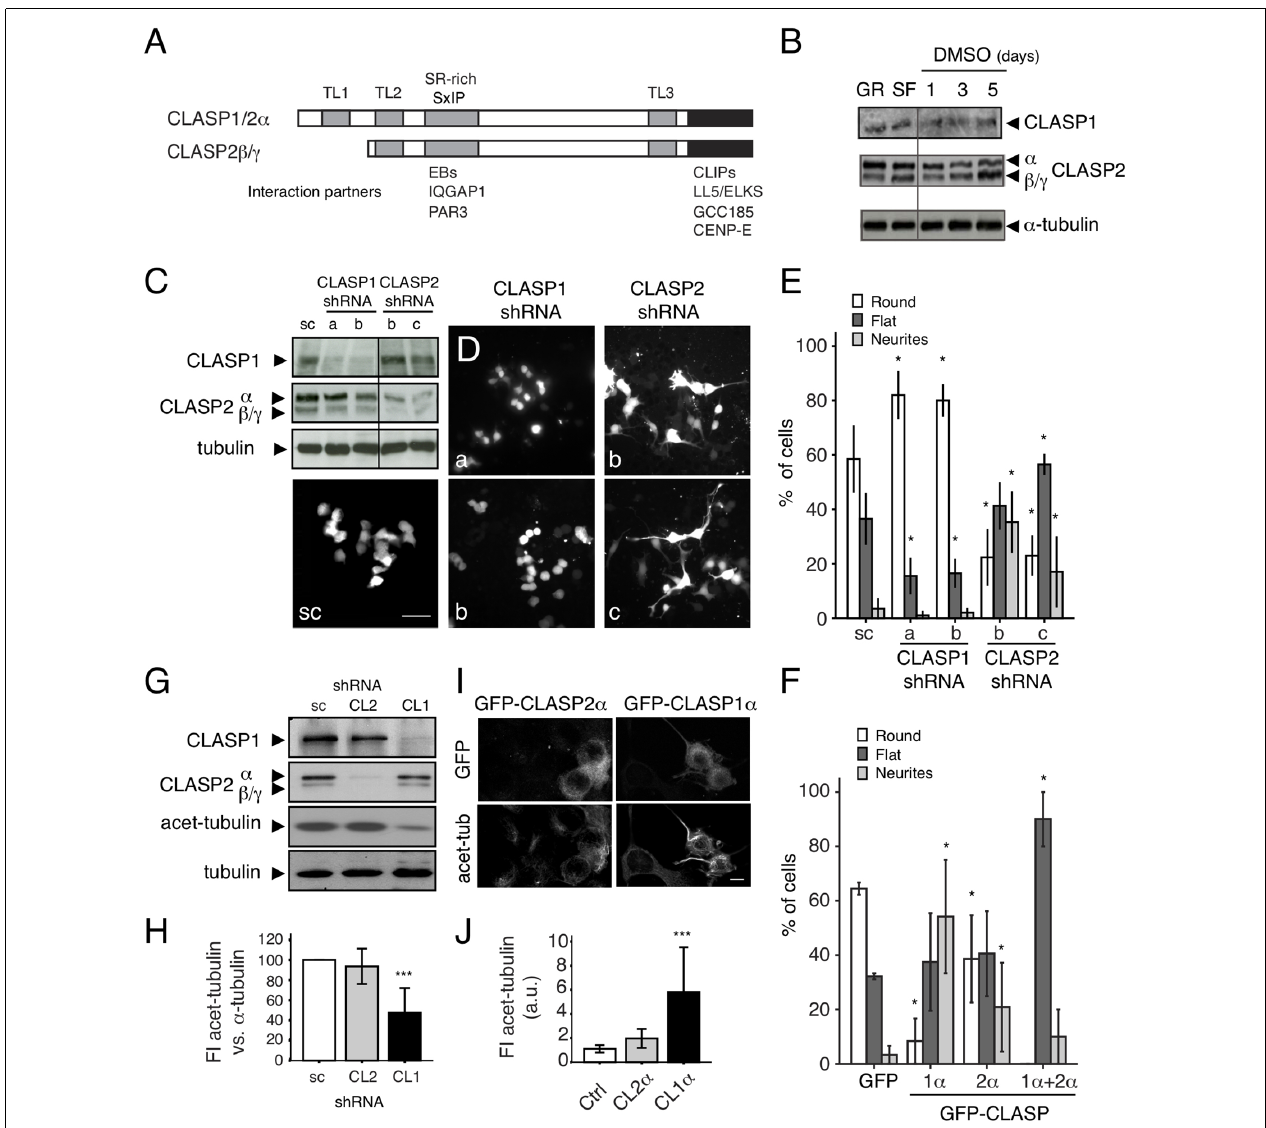
FIGURE 5 | Opposing roles of CLASP1 and CLASP2 in N1E-115 cells. (A) Schematic representation of CLASP domains and isoforms. The position of the TOGL (TL) and serine/arginine-rich (SR-rich) motifs is indicated by gray bars. Interaction partners and the regions in CLASPs with which they interact, are shown underneath. (B) CLASP1 and -2 expression (WB) in N1E-115 cells before and after differentiation, by overnight serum deprivation (SF for Serum Free) or with dimethyl sulfoxide (DMSO) for 1, 3, and 5 days. (C,D) Transient knockdown of CLASP1 and -2 in N1E-115 cells. WBs of lysates (C) and IF staining in N1E-115 cells (D) transfected with a scrambled shRNA construct or with different shRNA constructs targeting CLASP1 or CLASP2 (a and b for CLASP1 and b and c for CLASP2). Cells were either lysed for WB or fixed for IF, 72 h post-transfection. Cells were not serum-starved but were maintained in 10% fetal bovine serum (FBS)-containing medium. In (C) we used anti- α -tubulin as a loading control. In (D) , Scale bar = 50 µ m. shRNA constructs bear GFP as a reporter. (D,E) In the IF experiments, GFP-expressing CLASP1-depleted cells present mostly round morphology, whereas CLASP2-depleted cells show a differentiated morphology (flat or with neurites). This was quantified in E. Number of cells with each different morphology (round, flat or neurite-bearing cells) was compared in cells transfected with either CLASP1-or CLASP2-shRNAs vs. the scramble shRNAs (scramble/control). Student T -tests were performed. The effects had different extents depending on the shRNA used. (F) Overexpression of GFP-CLASP1 α induced dramatic neurite outgrowth and GFP-CLASP2 α only moderate neurite extension in N1E-115 cells. Transfected N1E-115 cells were counted for the presence of round, flat and neurite-bearing cells. Comparisons for statistical analyses were done between control cells (transfected with GFP) and cells transfected with either CLASP1 α , CLASP2 α , or CLASP1 α +CLASP2 α . Student T -tests were performed. Standard deviation (SD) is depicted in the bar graphs in (E,F) . (G–J) MT stability in CLASP knockdowns. (G) Lysates of N1E-115 cells stably depleted of either CLASP1 or CLASP2 were examined by WB, using antibodies against CLASP1, -2 and acetylated-tubulin (stable MTs). Total α -tubulin and GAPDH were used as loading controls. (H) Densitometric quantification of acetylated-tubulin vs. α -tubulin in representative WBs of control stable cells (scr) or cells deficient in CLASP1 or -2. (I) IF confocal images show N1E-115 cells transfected with GFP-CLASP1 α or GFP-CLASP2 α and stained for acetylated tubulin. (J) Quantification of FI in arbitrary units (a.u.) of acetylated tubulin in control (non-transfected) cells and cells ectopically expressing GFP-CLASP2 α or GFP-CLASP1 α from representative fluorescent images. SD is depicted in bar graphs of (H,J)